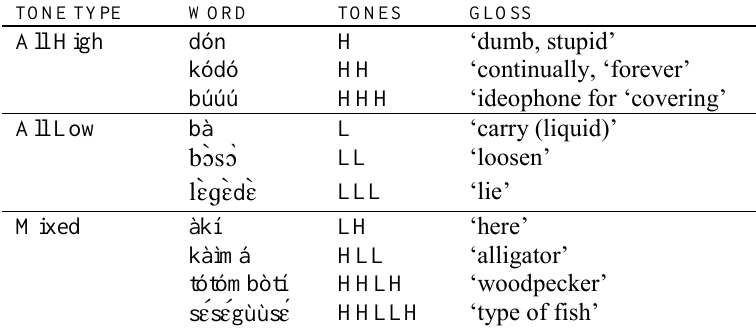
Table V: Tone patterns for words with invariant tones TONE TYPE